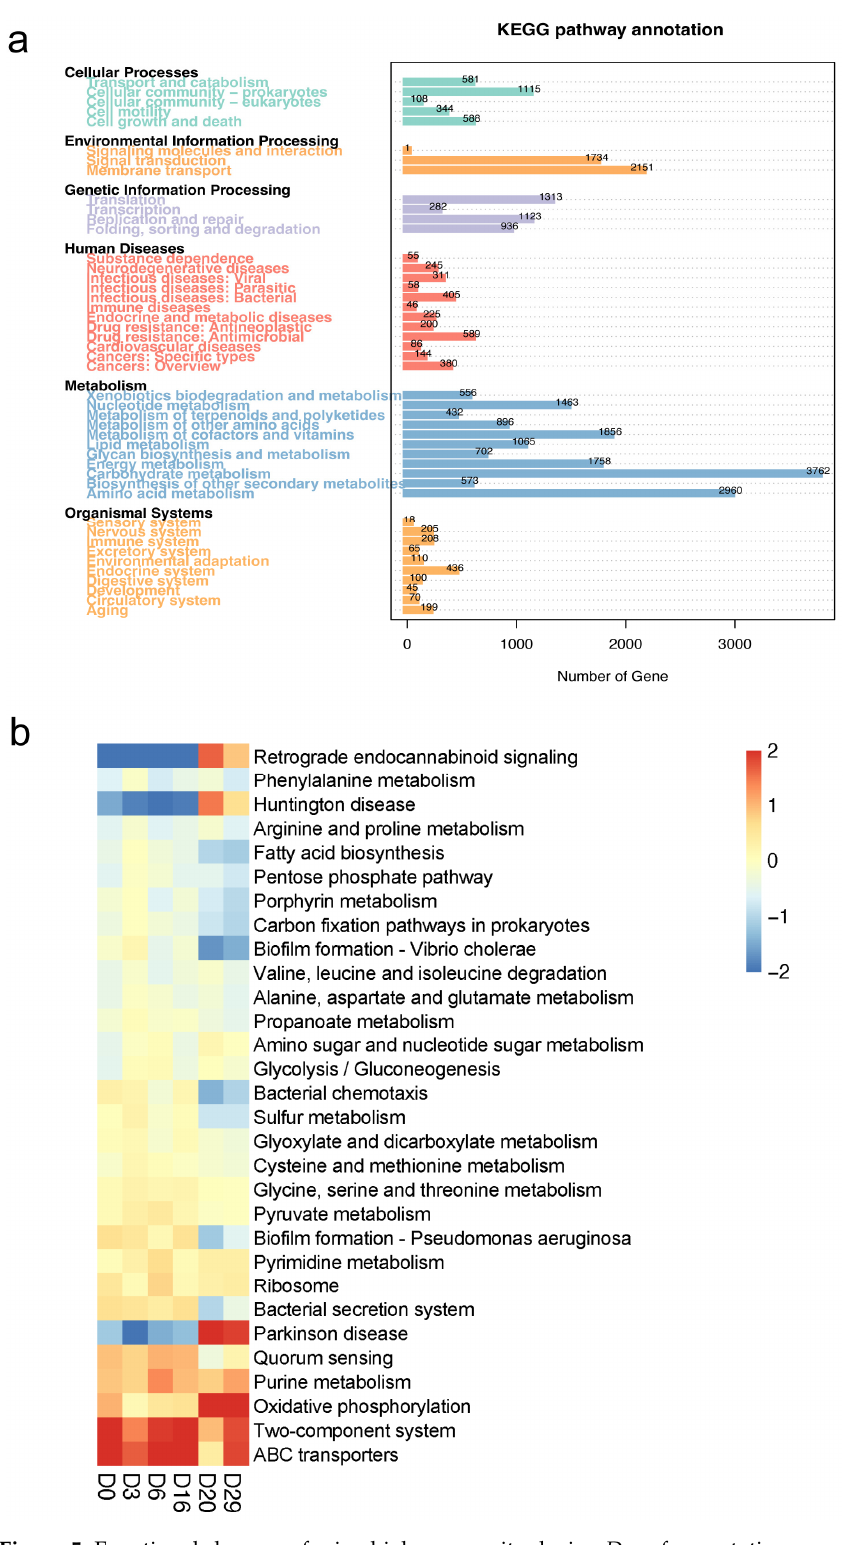
Figure 5. Functional changes of microbial community during Daqu fermentation process. Secondary pathway annotation of functional genes, the black font represents the primary metabolic pathway, and the colored fonts represent the secondary metabolic pathway. The length of the histogram indicates the abundance level of functional genes ( a ), heatmap of abundance of major metabolic pathways ( p < 0.05) ( b ). (Base on KEGG database).